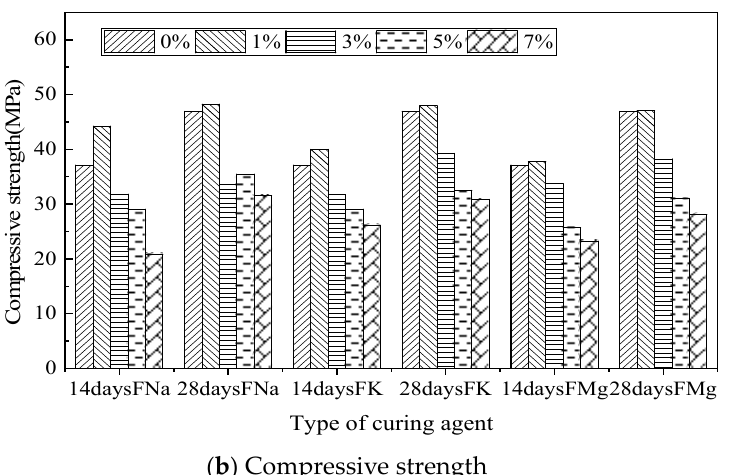
Figure 4. ( a , b ) Compressive and flexural strength of microcapsule self-healing cement specimens.